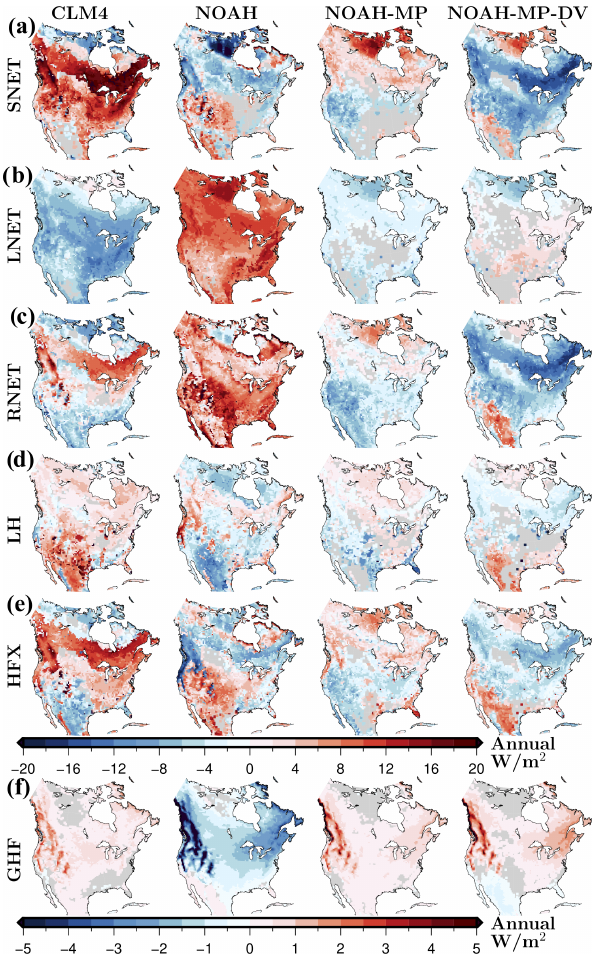
Figure 3. Anomalies of energy fluxes at the surface: (a) net short- wave radiation (SNET), (b) net longwave radiation (LNET), (c) soil net radiation (RNET), (d) latent heat flux (LH), (f) sensible heat flux (HFX) and (g) ground heat flux (GHF) for each LSM simulation relative to the LSM ensemble mean. Mean values are estimated as the temporal average for the period 1980–2013 using simulations performed with 50km resolution. Grid cells with a non-significant change at the 5% significance level are masked in grey.